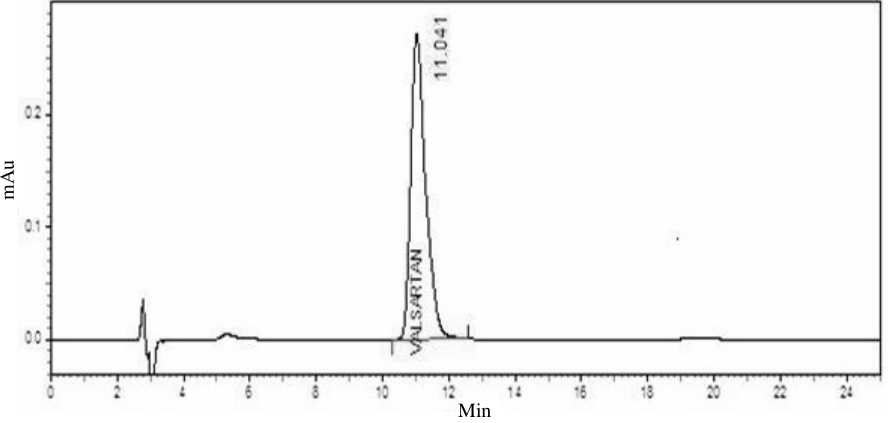
Figure 1. A typical chromatogram of standard